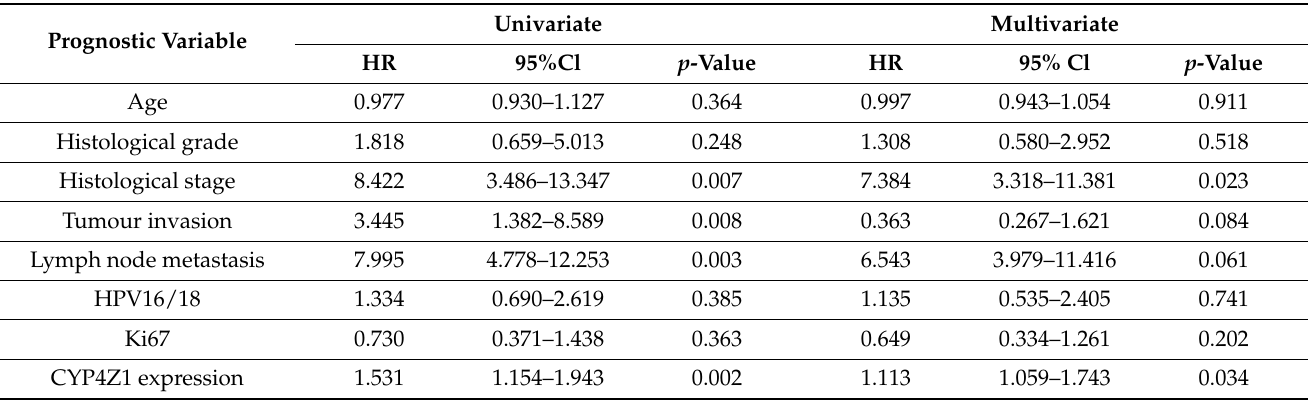
Figure 3. Kaplan–Meier survival curve of cervical cancer patients according to CYP4Z1 expression. Table 2. Univariate and multivariate analyses of prognostic variables correlated with cervical cancer patients’ survival.